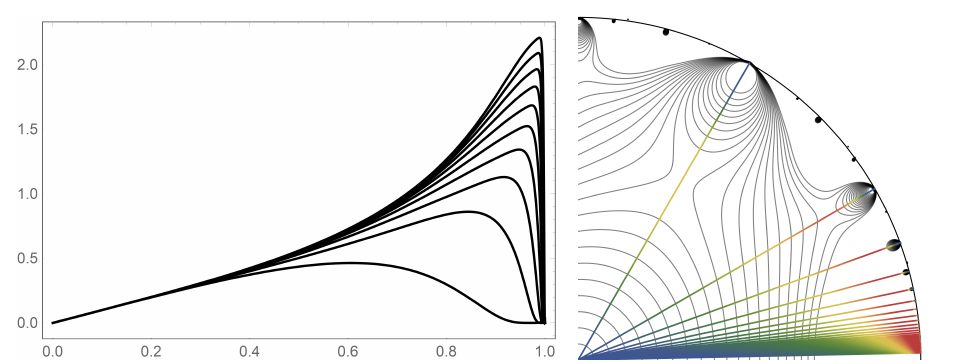
(cid:16) (cid:17) i π | for various values of p . The right panel shows the first 10 C ( 3 ) ; e Figure 17. Radial plots of | L 3 p symmetry angles. The top curve, which is also most skewed to the right, corresponds to p = 10 whereas the bottom curve corresponds to p = 1. It is true, in general, that | f N | along the symmetry angles exhibits an increasing maximum value with increasing p and that the position of the maximum migrates towards the unit circle. The right panel displays | f N | as “heat map” (blue—low value, red—high value) superimposed on the contour plot of | f N ( z ) | .